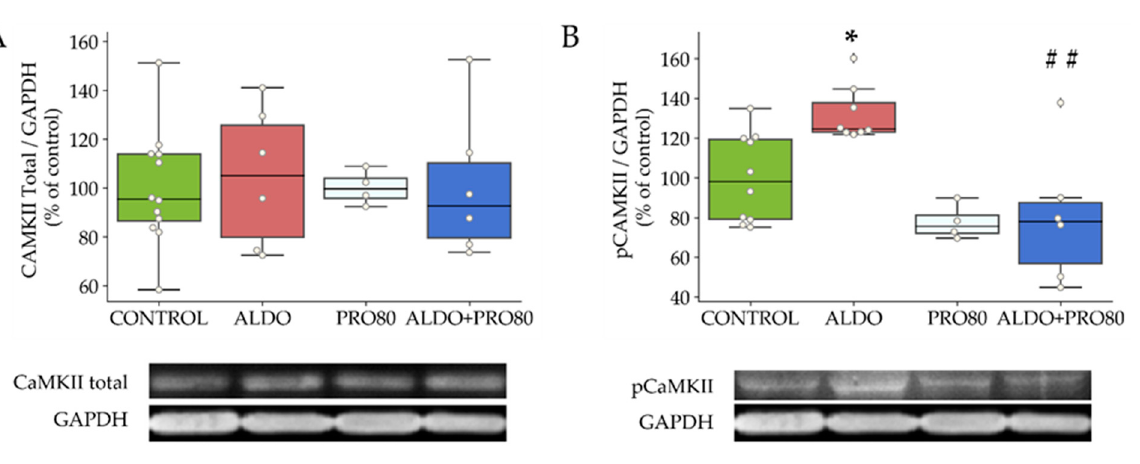
Figure 4. Effect of aldosterone and PRO80 treatment on myocardial protein expression of CAMKII, pCAMKII and oxCAMKII. Relative protein expression levels of Ca2+/calmodulin-dependent protein kinase II by western blot. A: Total CaMKII, B: Phosphorylation in threonine 286 (pCaMKII), C: Oxidation in methionines 281 and 282 (oxCAMKII). The boxplots show median, first and third quartile, and minimum and maximum values; the dots show individual values.* p < 0.05 vs control; ** p < 0.01 vs control; # p < 0.05 vs ALDO; ## p < 0.01 vs ALDO. CONTROL: Control group; ALDO: Aldosterone-salt group; PRO80: Proanthocyanidins-80% enriched extract group; PRO80+ALDO: Aldosterone plus proanthocyanidins-80% enriched extract group ( n = 8).